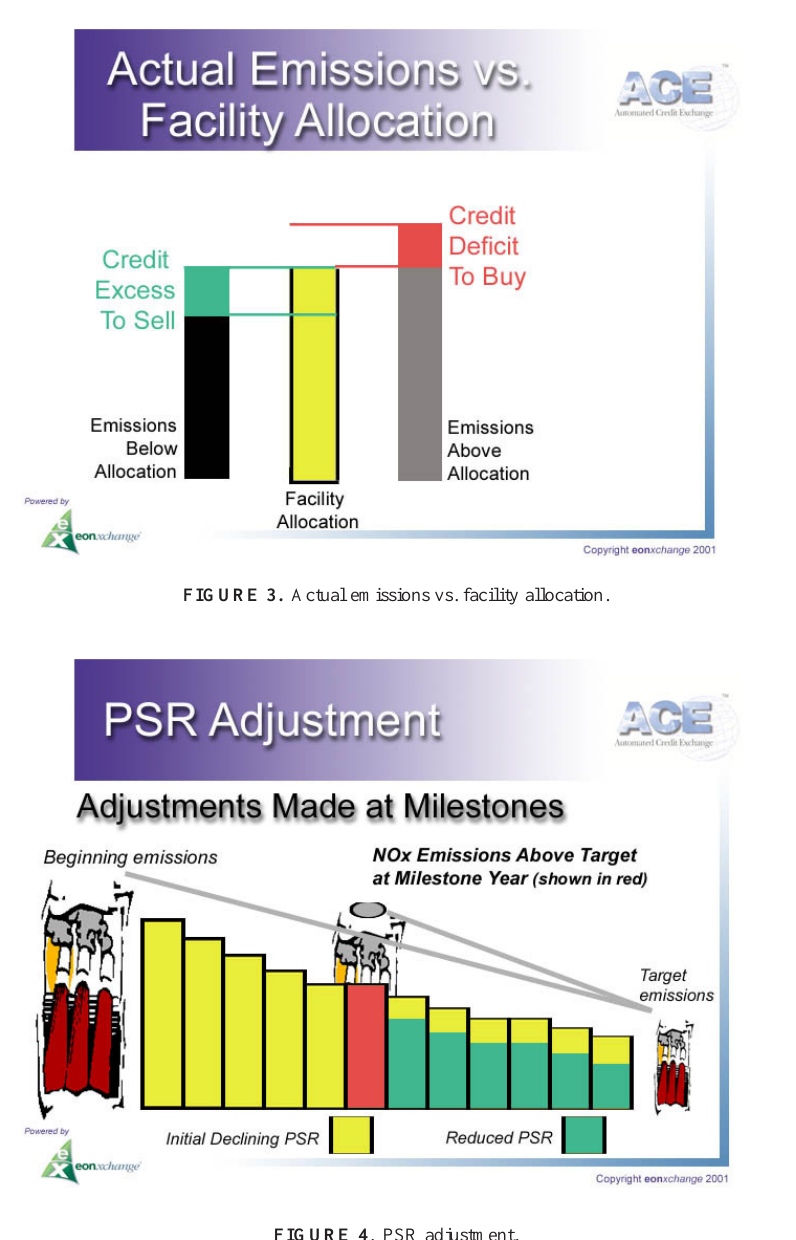
FIGURE 4 . PSR adjustment.